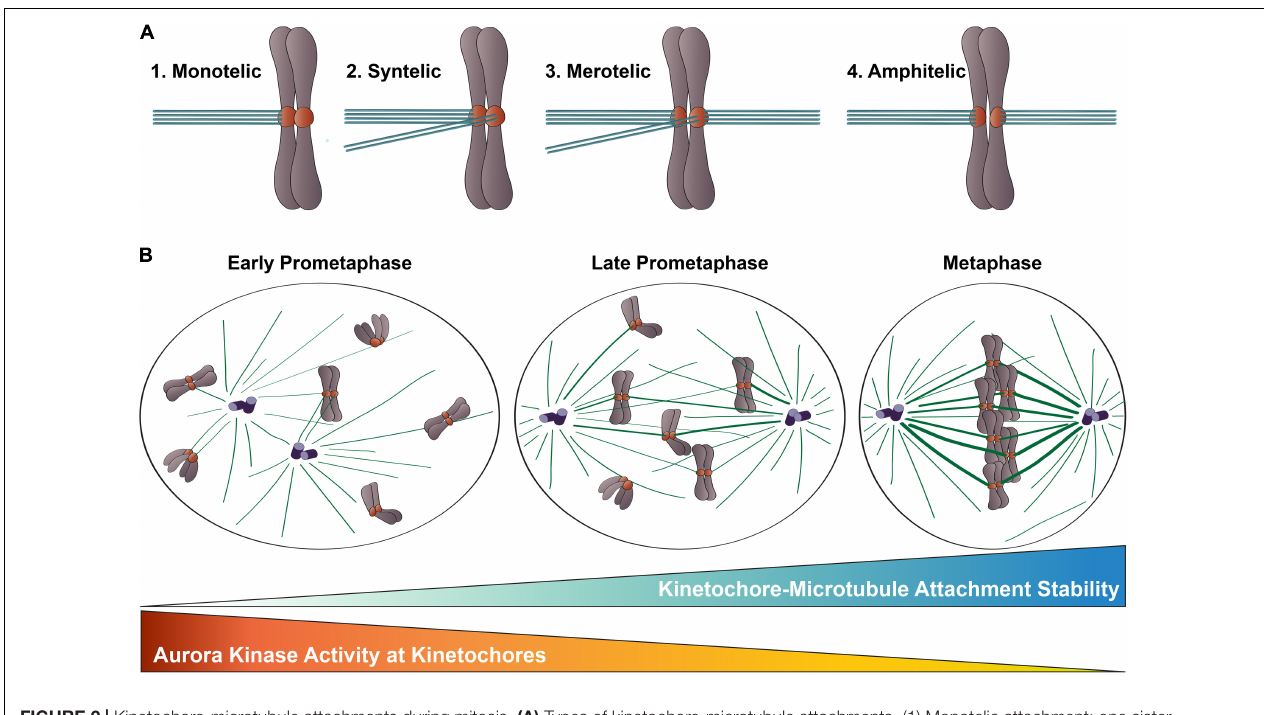
FIGURE 2 | Kinetochore-microtubule attachments during mitosis. (A) Types of kinetochore-microtubule attachments. (1) Monotelic attachment: one sister kinetochore is attached to microtubules from one spindle pole and one sister is unattached; (2) Syntelic attachment: both sister kinetochores are attached to microtubules emanating from the same spindle pole; (3) Merotelic attachment: one sister kinetochore is attached to microtubules from both spindle poles; and (4) Amphitelic attachment (correct): one sister kinetochore is attached to microtubules from one pole and one sister kinetochore is attached to microtubules from the opposite pole. (B) Chromosome congression during mitotic progression. In early prometaphase, kinetochore-microtubule attachments errors are common, kinetochore-microtubule attachments are short-lived and labile, and Aurora B kinase activity at kinetochores is high. As mitosis progresses,